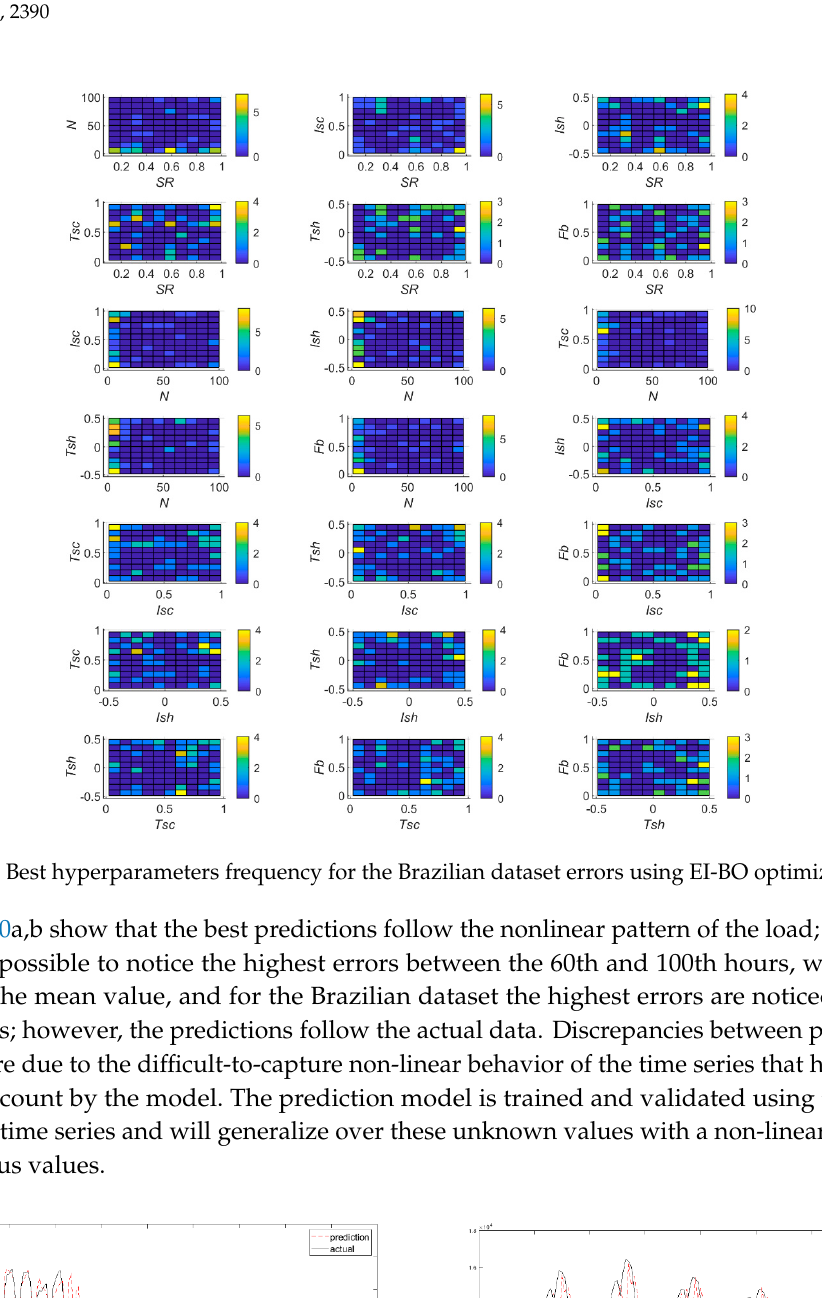
Figure 9. Best hyperparameters frequency for the Brazilian dataset errors using EI-BO optimized ESN. Figure 10. Visualization of predictions (dashed) over actual (continuous) values for the ( a ) Polish and ( b ) Brazilian test sets.